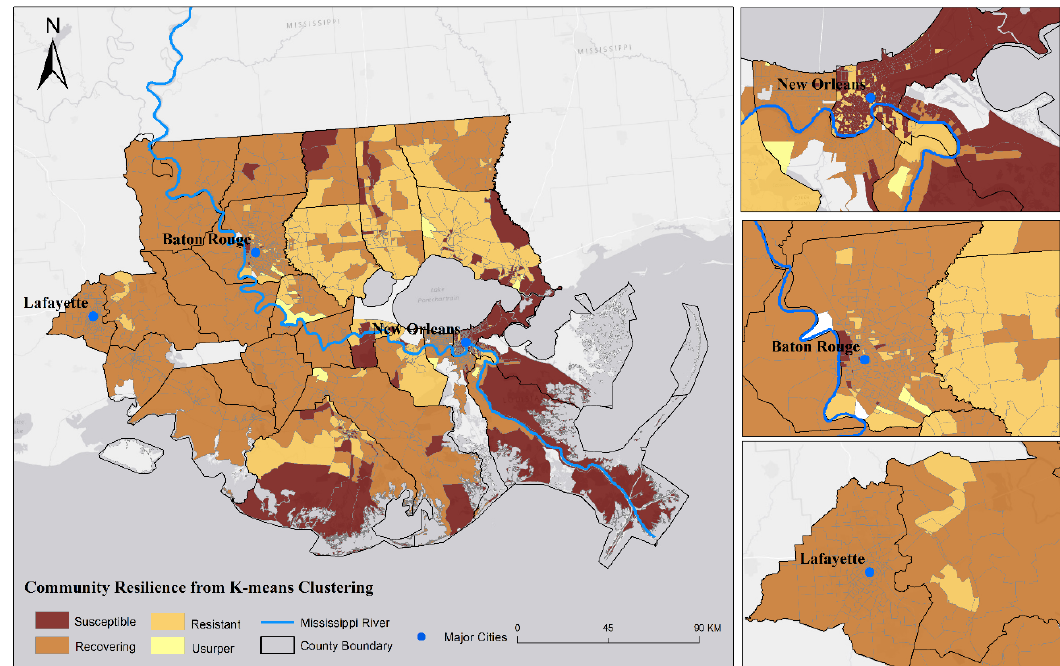
Figure 7. Community Resilience Classification from K-means Clustering.